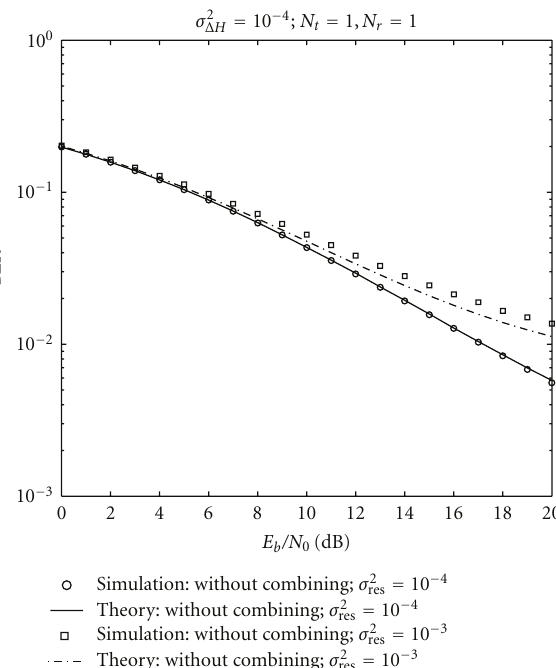
Figure 2: SINR reduction by frequency o ff set in MIMO-OFDM systems.